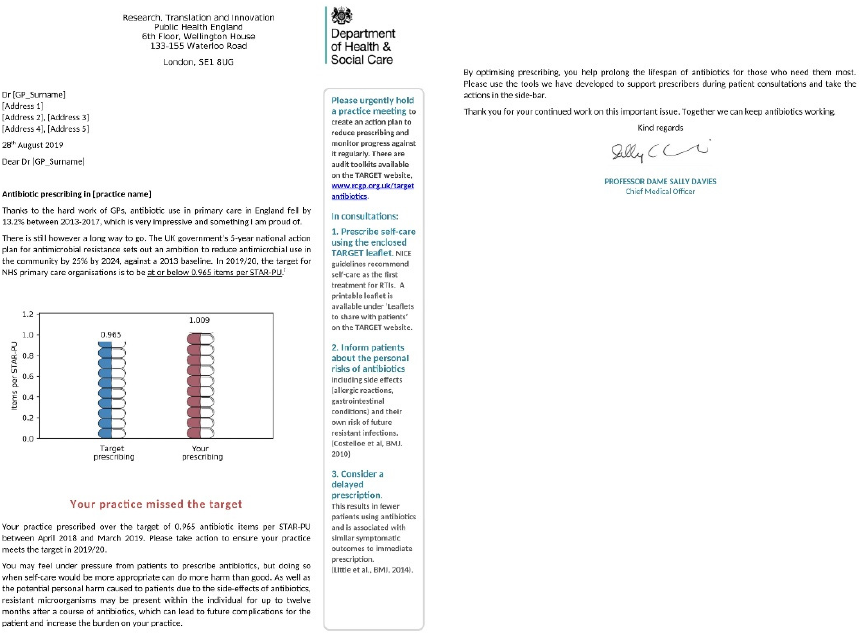
Figure 2. Example 1 of the workshop GP feedback letter with a bar graph in the centre and three key action points boxed to the right of the main text.